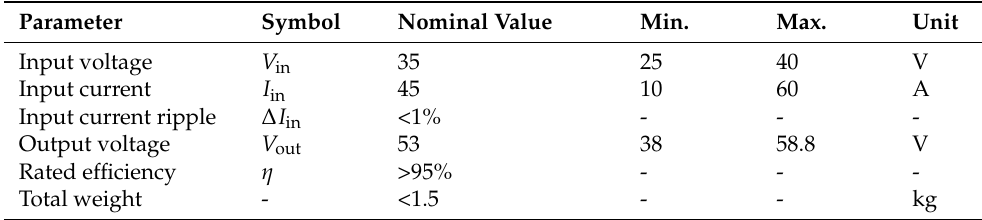
Table 1. The converter’s technical